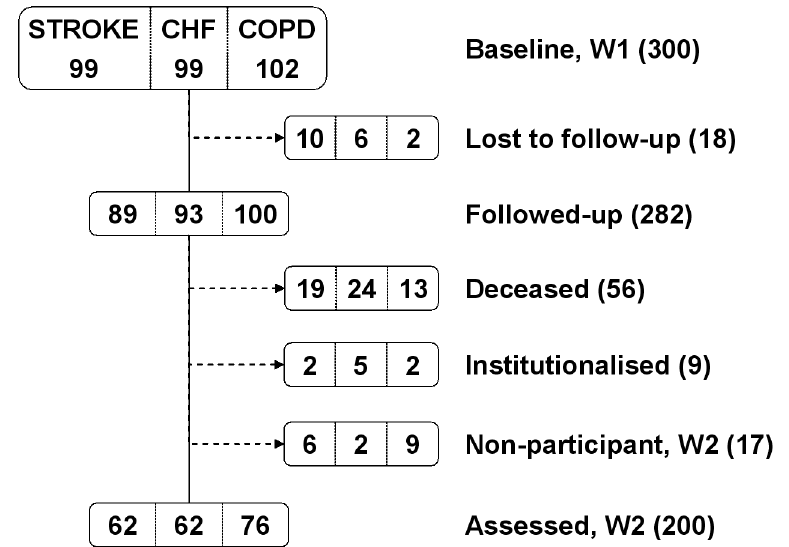
Figure 1. Attrition at follow-up for all patients and diagnostic groups. doi: